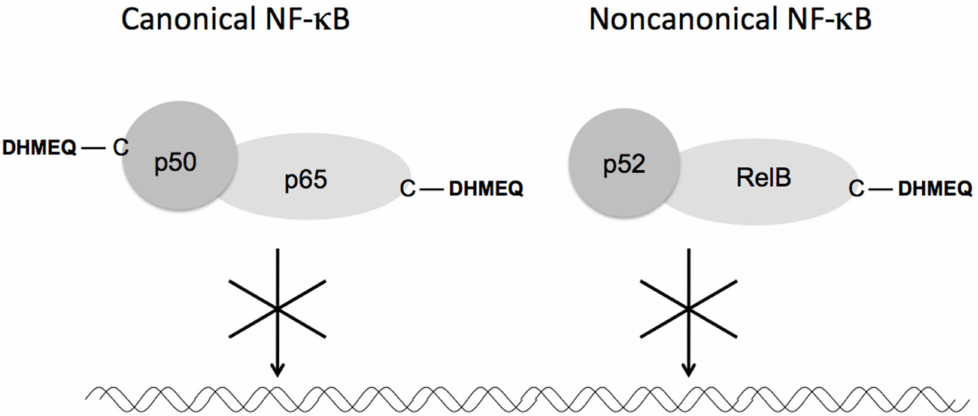
Figure 4. Inhibition of canonical and non-canonical NF- κ B by DHMEQ. DHMEQ binds to specific cysteine residues in p65, p50, and